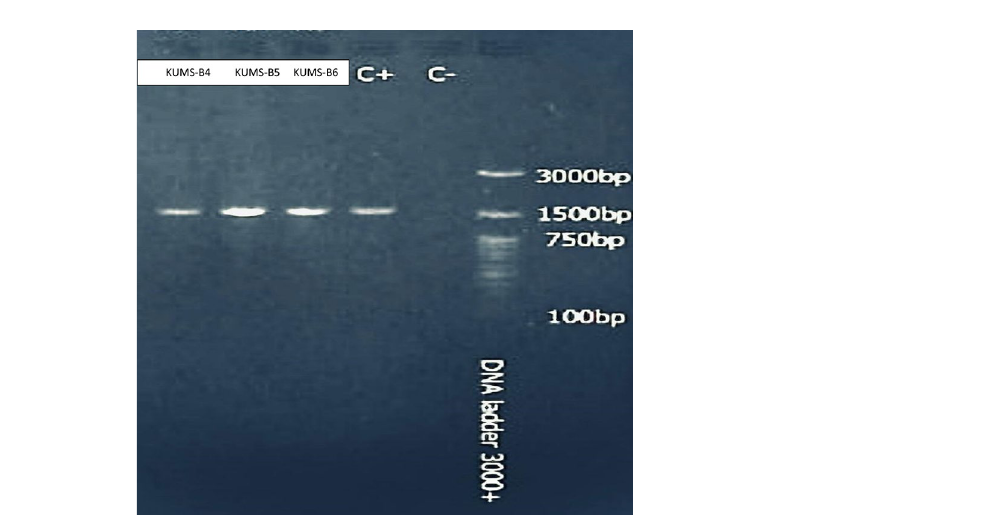
Figure 4. Gel electrophoresis of PCR products using 27F and 1492R primers. The 1.5 Kb amplified 16S rDNA fragments of isolated actinobacteria monitored on a 1.5% agarose gel. RCR product of 16S rRNA sequence of isolates on a 1.5% agarose gel from left to right: KUMS-B4, KUMS-B5, KUMS-B6, positive control, negative control and